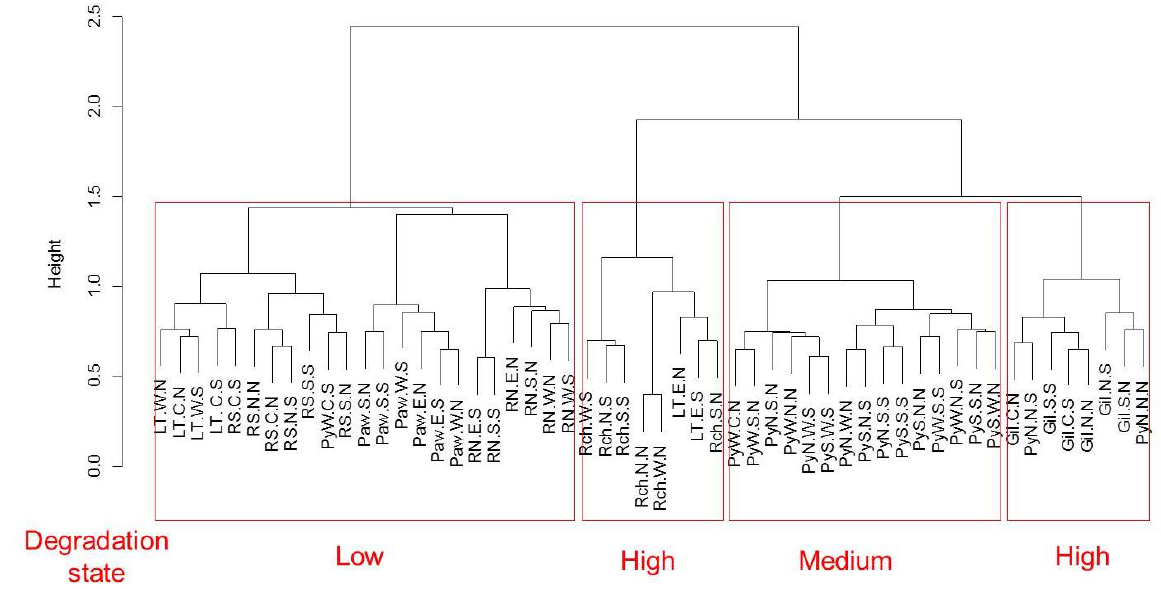
Figure A1. Results of hierarchical clustering using the Canberra distance matrix to identify three vegetation states based on plant community composition (see Experimental section in main text). Codes represent each of 54 modified Whittaker plots used for vegetation sampling (see Table A1 for explanation of nomenclature and description of plant community attributes). The two High degradation groups are combined into a single vegetation state based on similarity of plant community attributes listed in Table A1 (see Experimental section in main